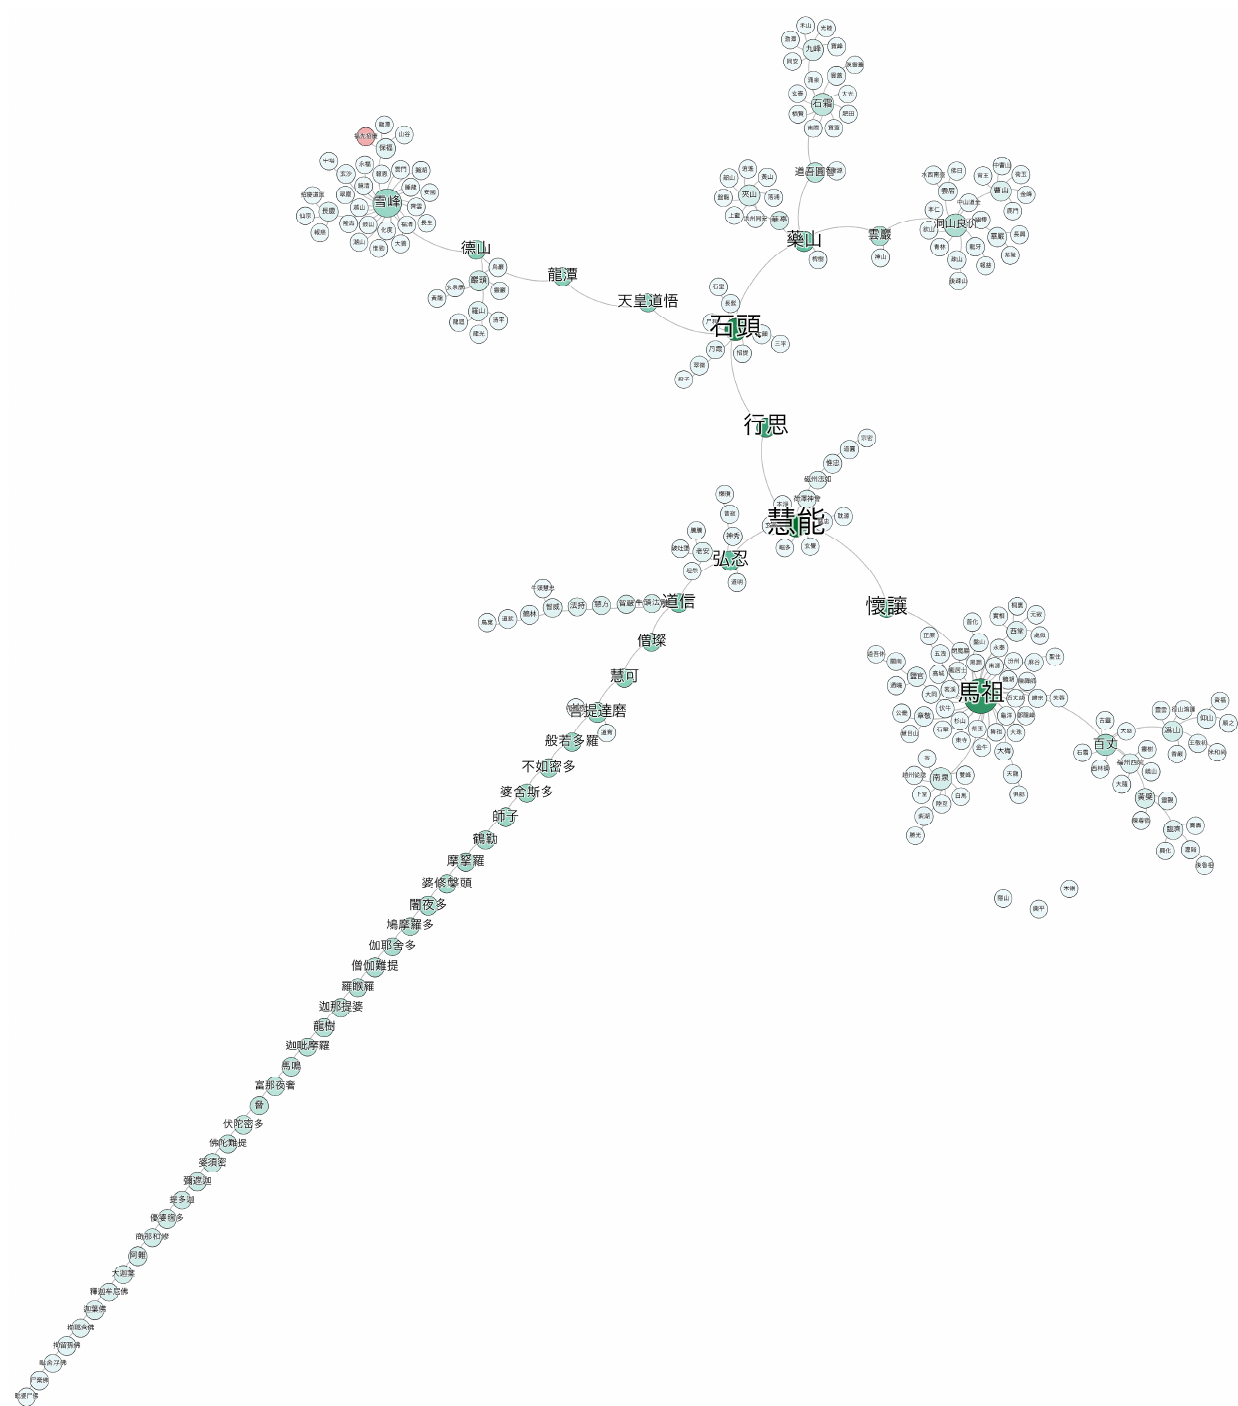
Figure 1. Overview of the ZTJ ’s version of Chan genealogy. Generated with Gephi (version 0.9.5), with Force Atlas 2. The size of the nodes is proportional to their degree centrality (min. size: 10, max. size: 20). The color (shades of green) of the nodes and the size of the nodes’ labels (min. size: 0.5, max. size: 2.5) are proportional to their betweenness centrality. Once spatialized, Force Atlas 2 was run a second time with the “Prevent overlap” option checked. The author of the ZTJ ’s original preface, Fuxian Zhaoqing 福先招慶 (i.e., Wendeng), is colored in red.